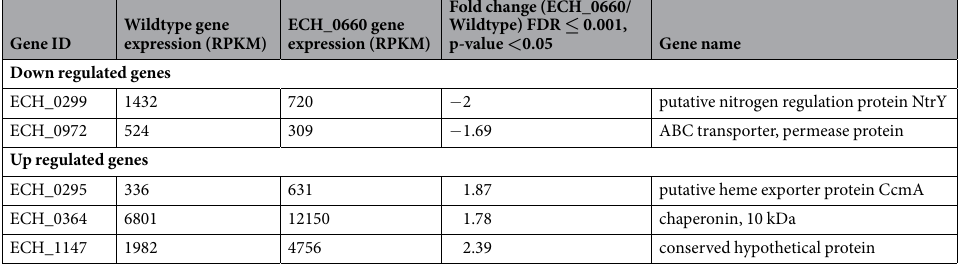
Table 4. E . chaffeensis genes differentially transcribed in ECH_0660 compared to